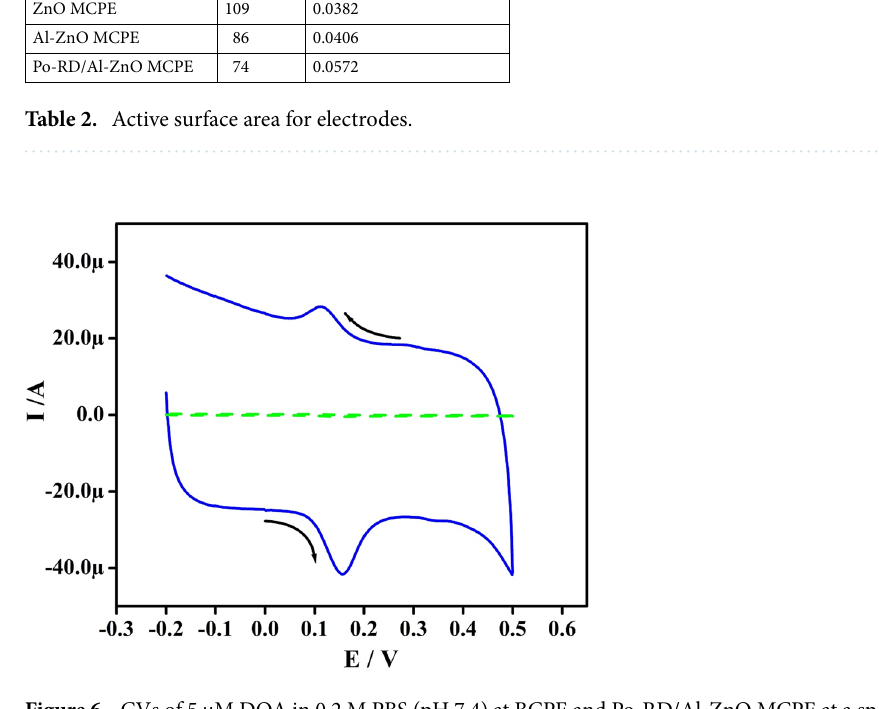
Figure 6. CVs of 5 μM DOA in 0.2 M PBS (pH 7.4) at BCPE and Po-RD/Al-ZnO MCPE at a speed rate of 50 mV s −1